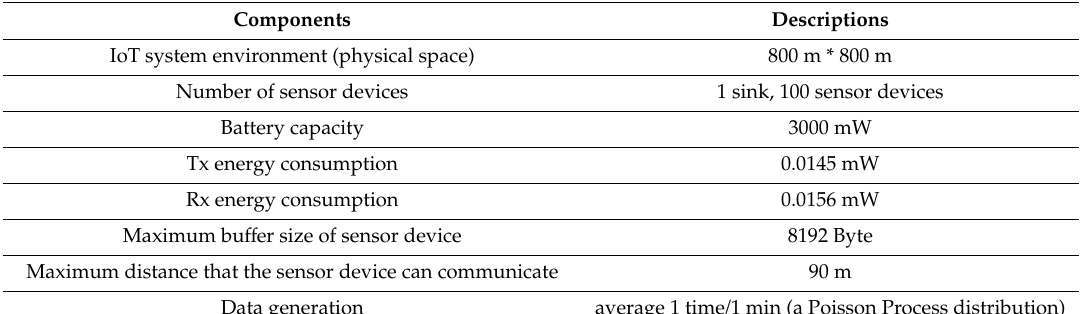
Simulation environment of group management medium access control (GM-MAC) without mobility.